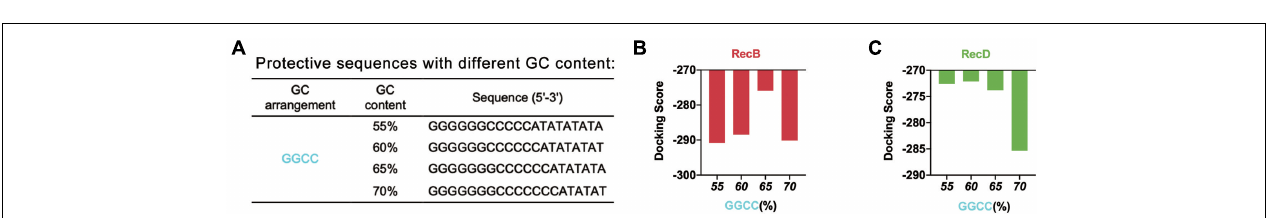
Frontiers in Bioengineering and Biotechnology |